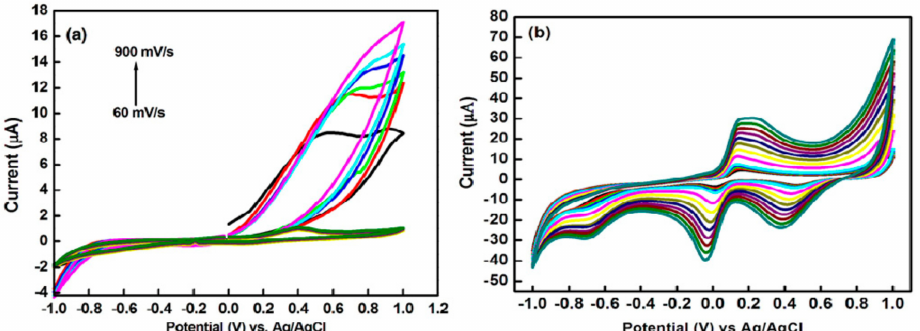
Figure4. CyclicvoltammogramsforaGd 2 O 3 nanoparticles-coatedgoldelectrodefor1mM( a )hydrazine and ( b ) p-nitrophenol at di ff erent scan rates ranging from 60 to 900 mV /